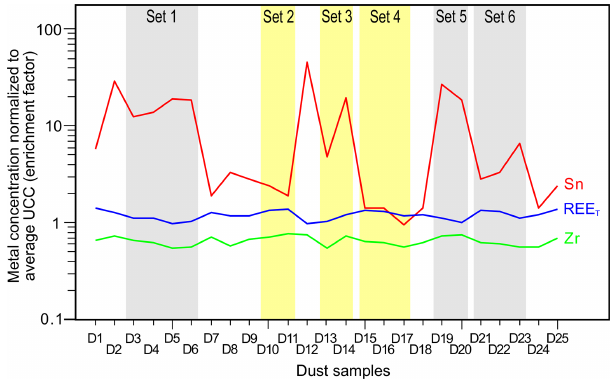
Figure 10. Time-series variation in trace element compositions of Asian dust normalized to the average values of the